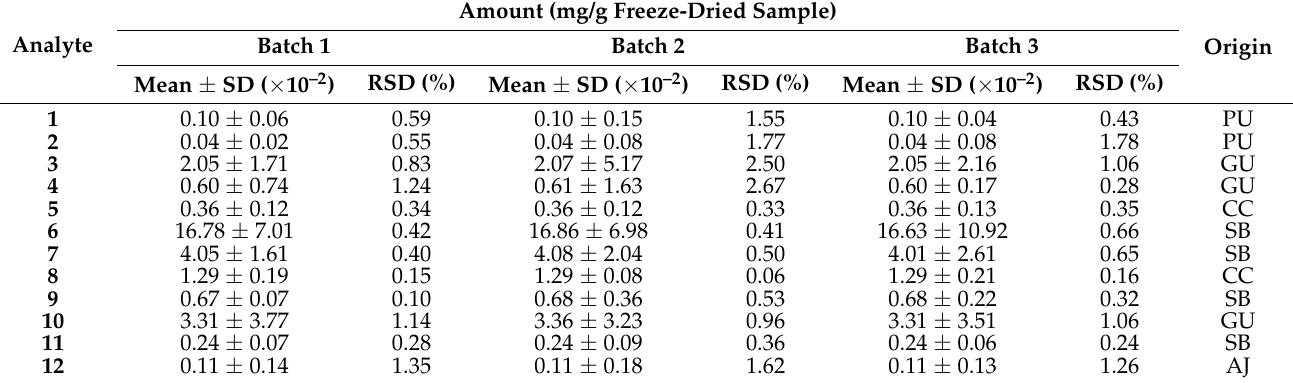
Table 6. Amounts of the 12 markers in the 70% methanol extracts from the SRT water decoctions determined by HPLC–PDA ( n =